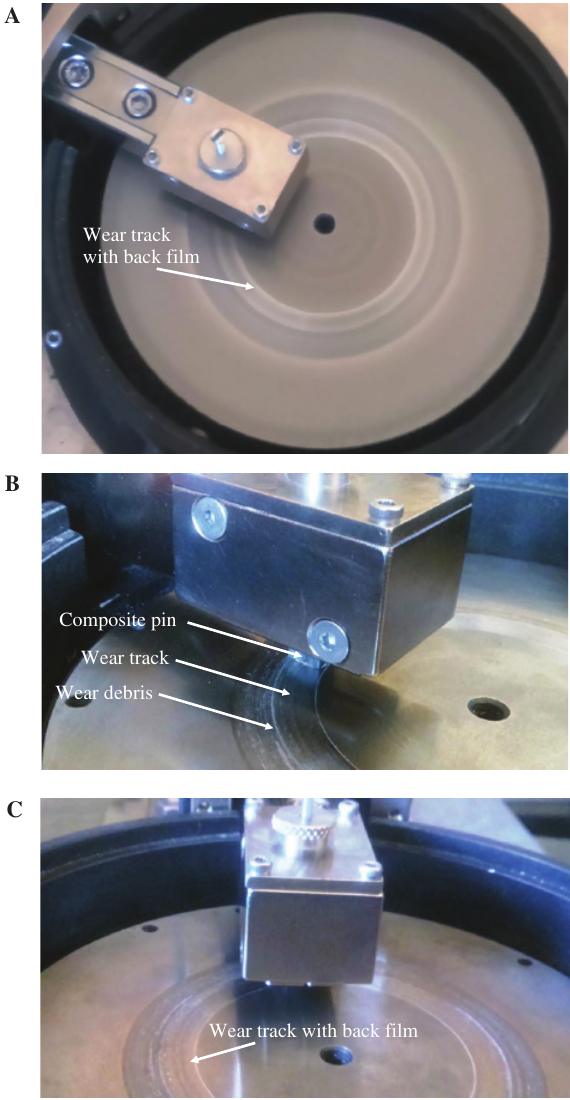
Figure 12: Photo image of the Back film formation on the pin-on- disk: (A) 5% of CNS, (B) 30% of CNS, and (C) 35% of